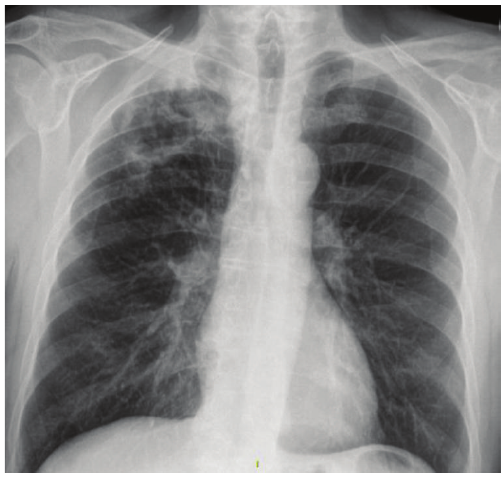
Figure 1: Chest X-ray at presentation.